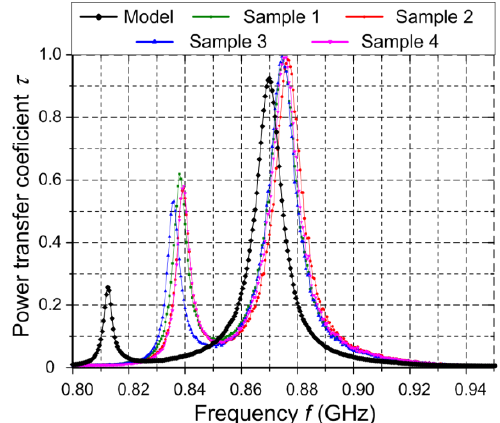
Figure 9. Impedance parameters of transponder antenna as a function of frequency f : ( a ) Resistance component; ( b ) Reactance component; Z TA — antenna impedance; Re — real part of complex number; Im — imaginary part of complex number; f — frequency.